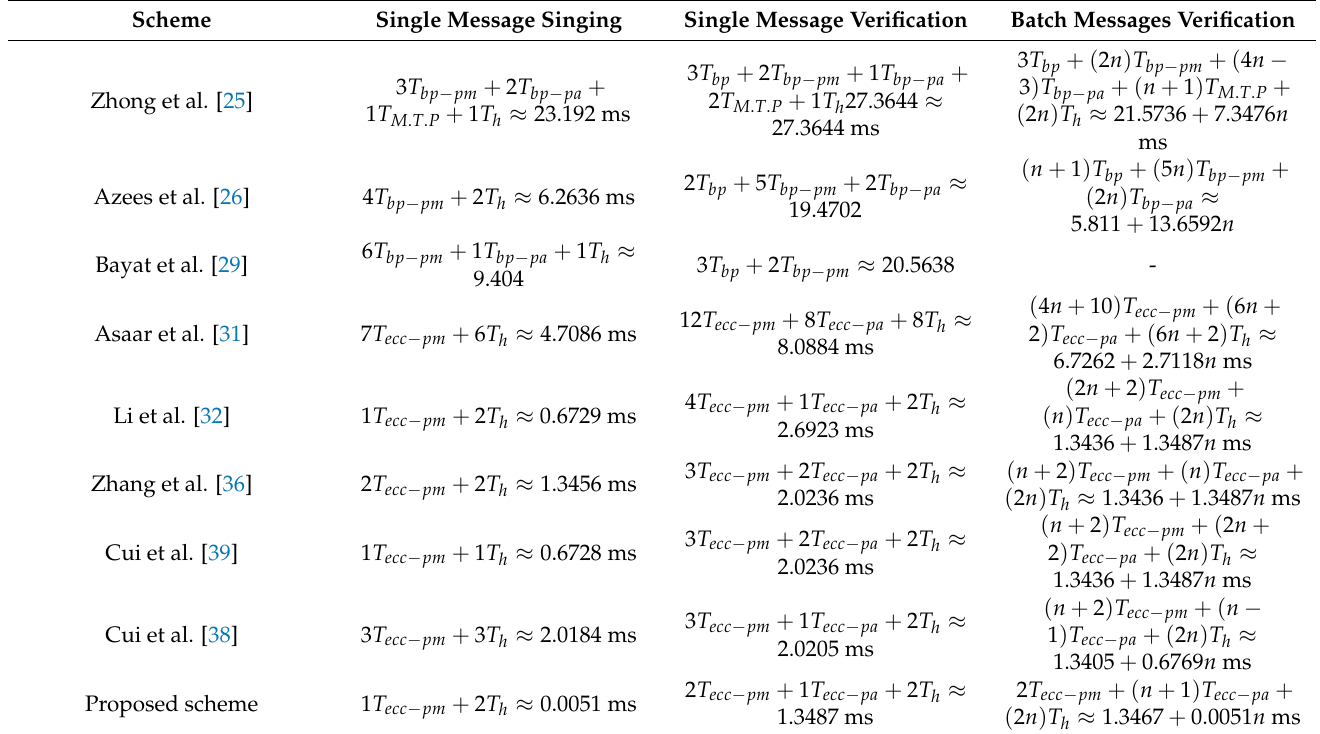
Table 4. Computation cost